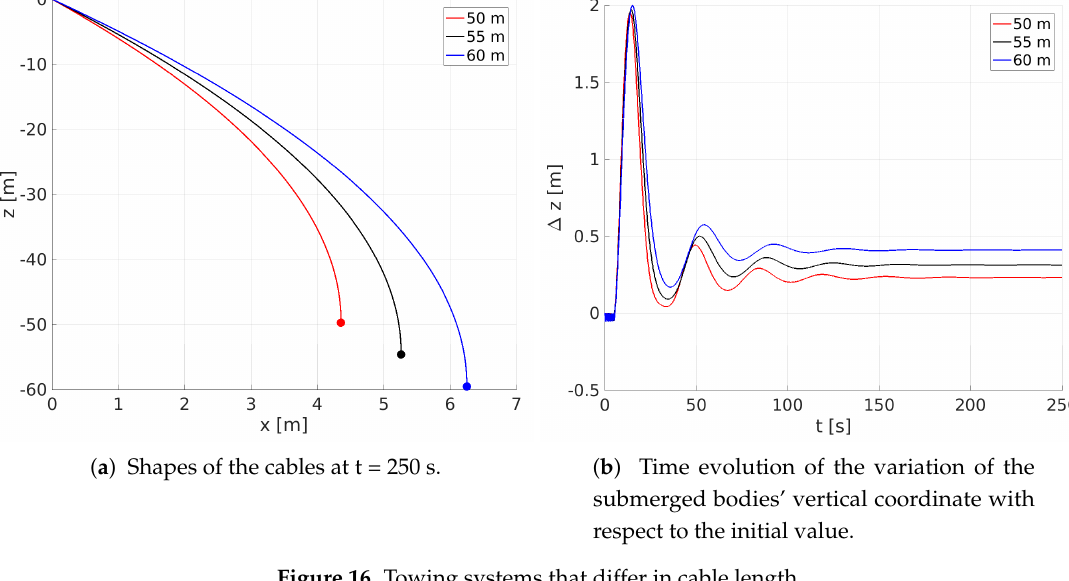
Figure 16. Towing systems that differ in cable length.